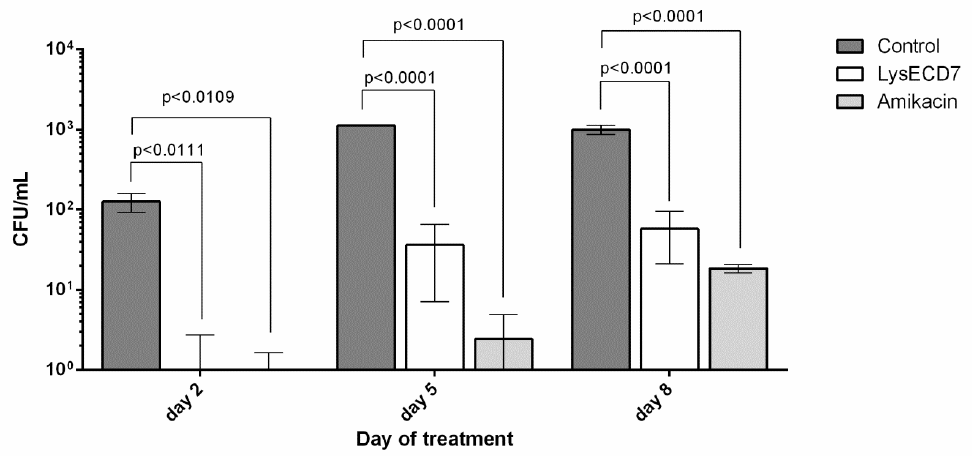
Figure 5. Count of culturable bacteria in the formed biofilms in diffusion chambers in vivo during performed therapy. Data are shown as mean ± standard deviation. Significant differences with the vehicle control group are shown as p values, otherwise no statistical difference was found (two-way ANOVA with Dunnett’s multiple comparisons test). On the 5 th day, a significant difference between endolysin and antibiotic groups was also detected ( p = 0.0001).